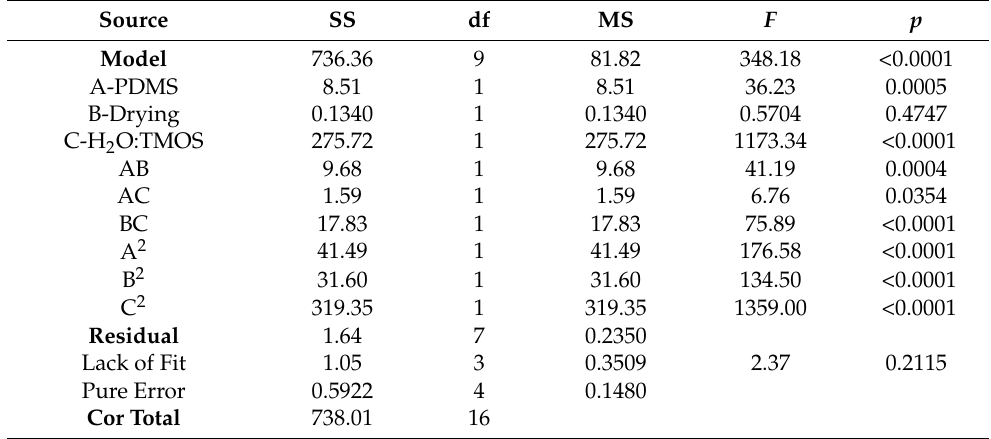
Table 3. Summary of optimized parameters of β -galactosidase entrapping in silica composites.